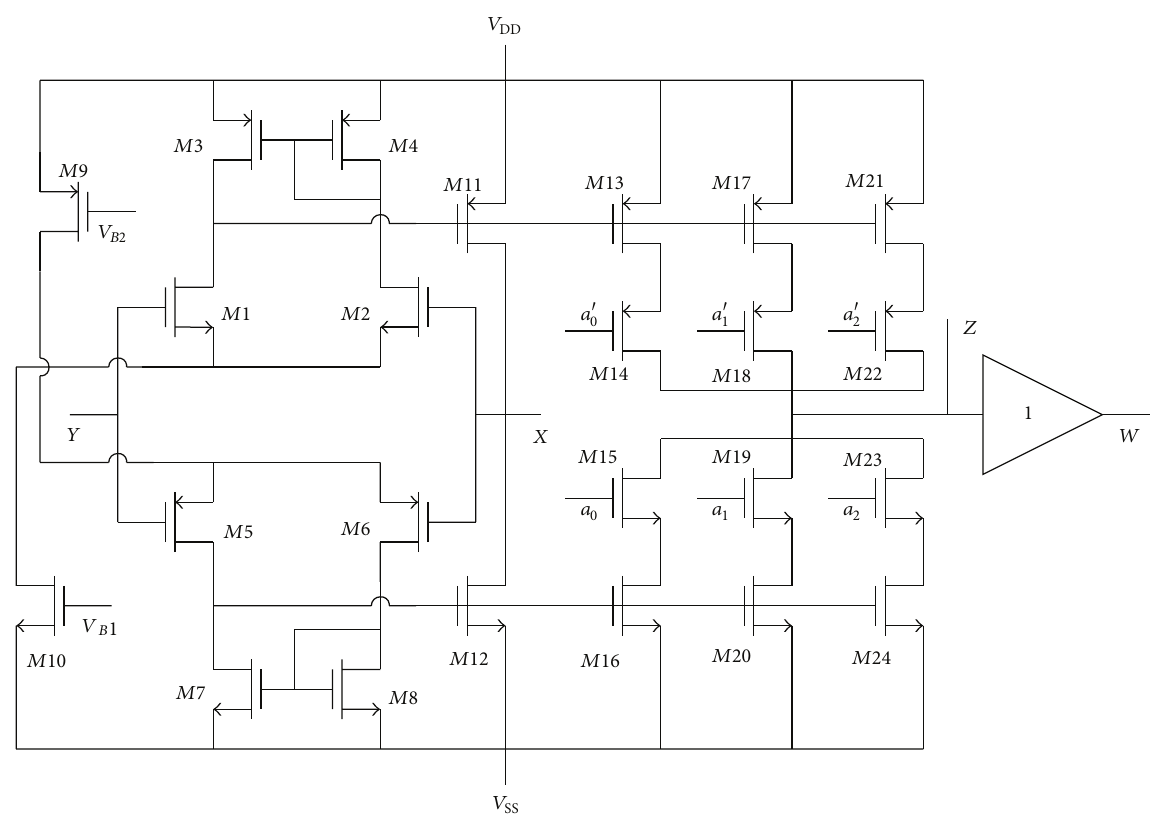
Figure 1: CMOS structure of DPCFA with gain 𝐾 + (adopted from